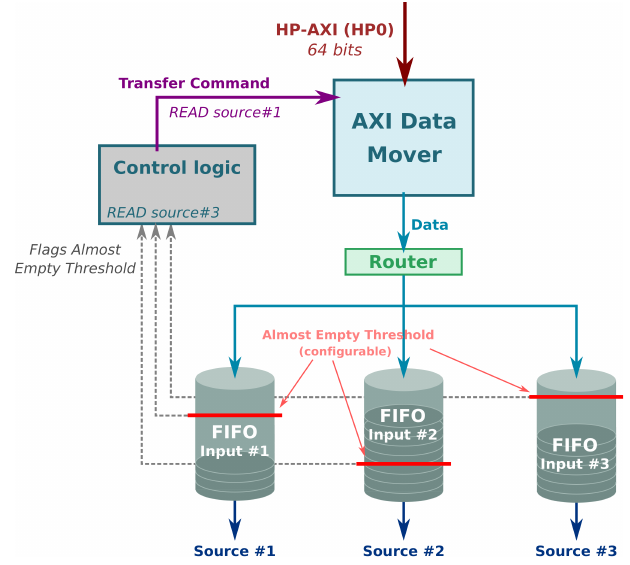
Figure 7. Overview of the memory controller for the ZynQ-7000